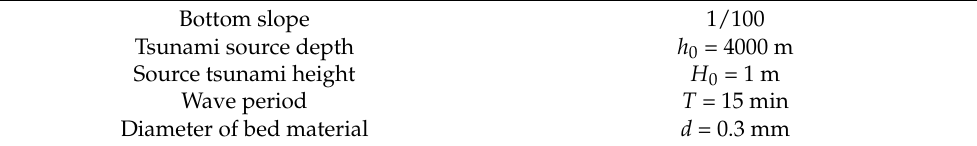
Table 2. Calculation conditions.